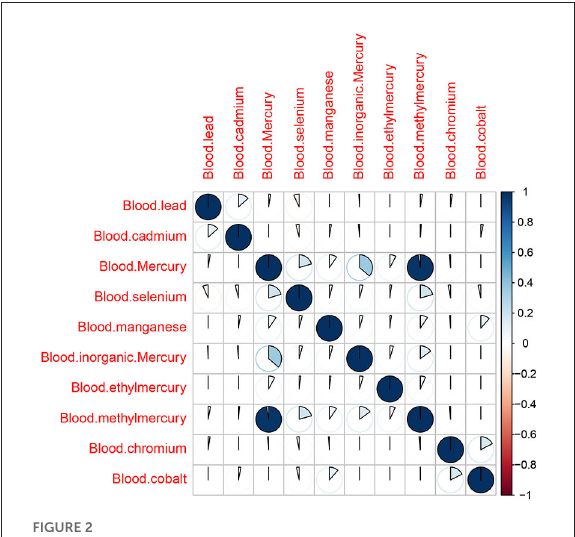
FIGURE2 Correlation matrix among 10 metal elements.